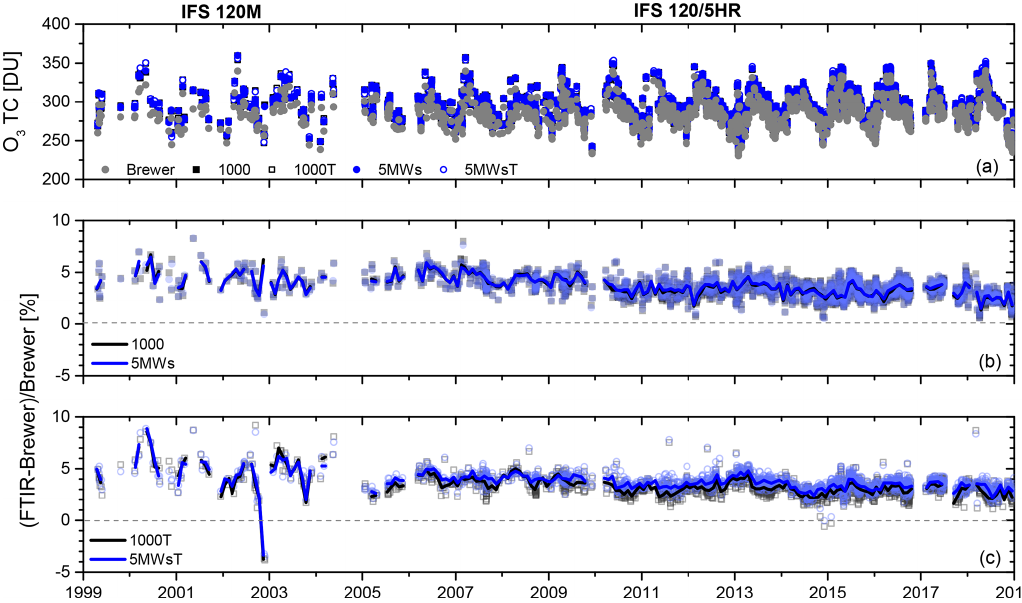
Figure 4. Summary of the FTIR–Brewer comparison from 1999 to 2018. (a) Time series of O 3 TCs (DU) as observed by Brewer and FTIR 1000/1000T and 5MWs/5MWsT setups. (b) Time series of relative differences (RD) for the setups 1000 and 5MWs, which were calculated as RD ( % ) = 100 × ( O 3 TC X − O 3 TC Y )/ O 3 TC Y , where X and Y refer to FTIR and Brewer, respectively. (c) As for (b) , but for the setups 1000T and 5MWsT. Solid lines in (b) and (c) correspond to monthly medians. Table 2. Summary of statistics for the FTIR–Brewer comparison for the setups 1000/1000T, 4MWs/4MWsT, and 5MWs/5MWsT: the median ( M , in %) and standard deviation ( σ , in %) of the relative differences and Pearson correlation coefficient ( R ) of the direct comparison are shown for the periods 1999–2004, 2005–May 2008, and June 2008–2018 and for the entire time series (1999–2018). Also shown are the median of the theoretical TPE ( M TPE ), SE ( M SE ), and TE ( M TE ) uncertainties. The number of coincident FTIR–Brewer measurements is 93, 185, and 1892 for the three periods, respectively, and 2170 for the whole dataset. The strategies showing the best performance in terms of smallest σ and M TE are highlighted in bold for each